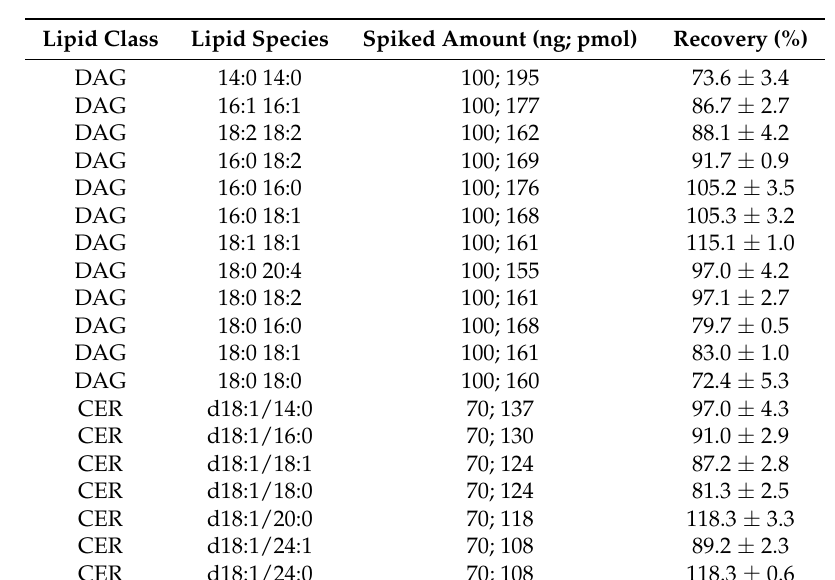
Table 3. Recovery.